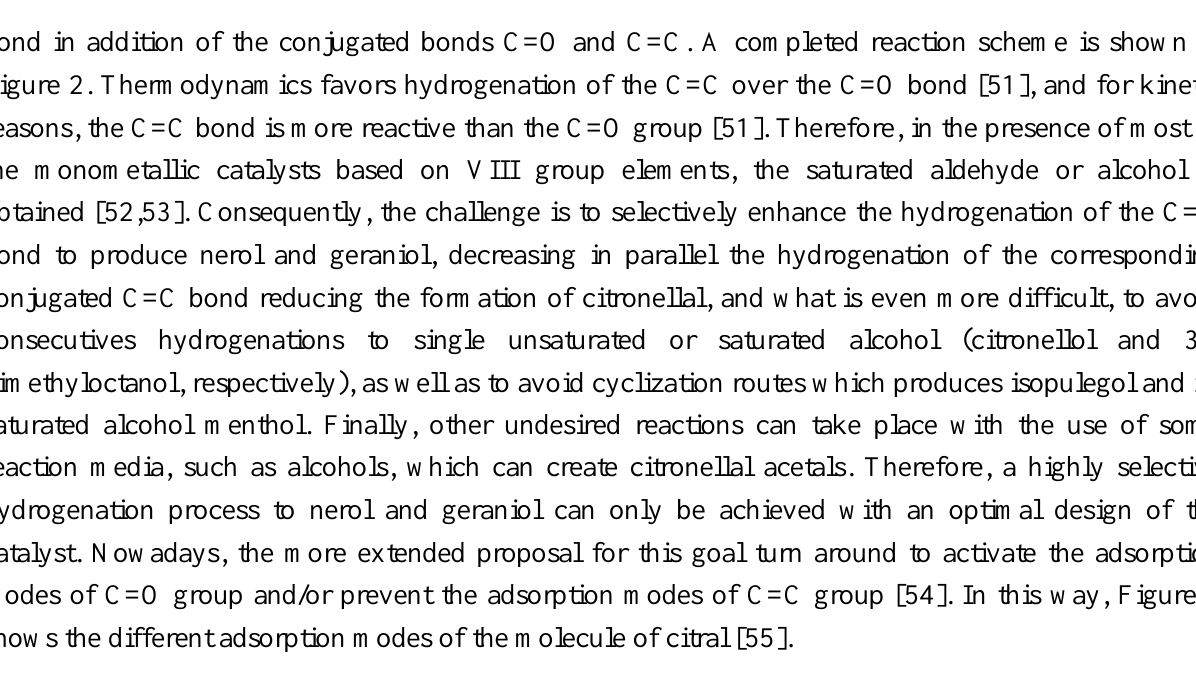
Figure 2. Reaction scheme of the citral hydrogenation. Adapted from